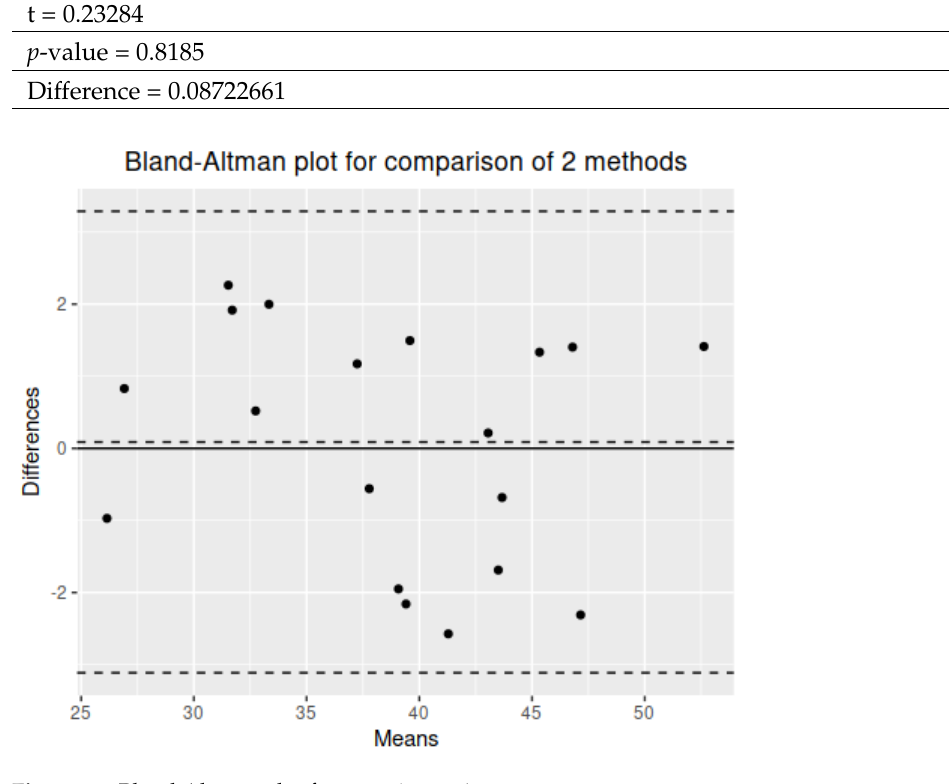
Figure 11. Bland Altman plot for experiment 1.